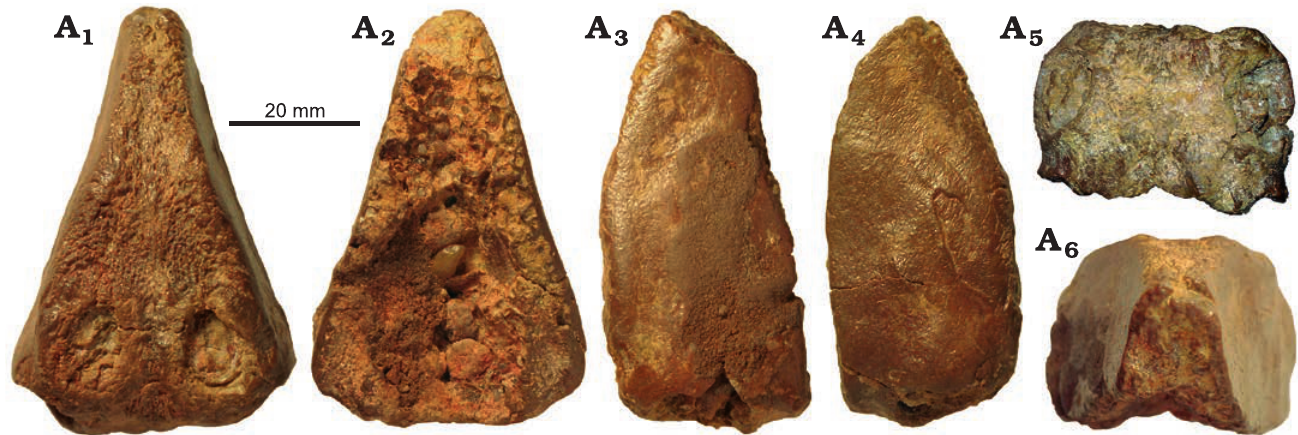
Fig. 3. Anhanguerid pterosaur Nicorhynchus fluviferox comb. nov., FSAC­KK 10701, Hassi El Begaa, Er Rachidia Province, Morocco, ?Albian–lower Cenomanian. In anterior (A 1 ), posterior (A 2 ), left (A 3 ) and right (A 4 ) lateral, palatal (A 5 ), and dorsal (A 6 ) views. Photographs courtesy of Megan L.